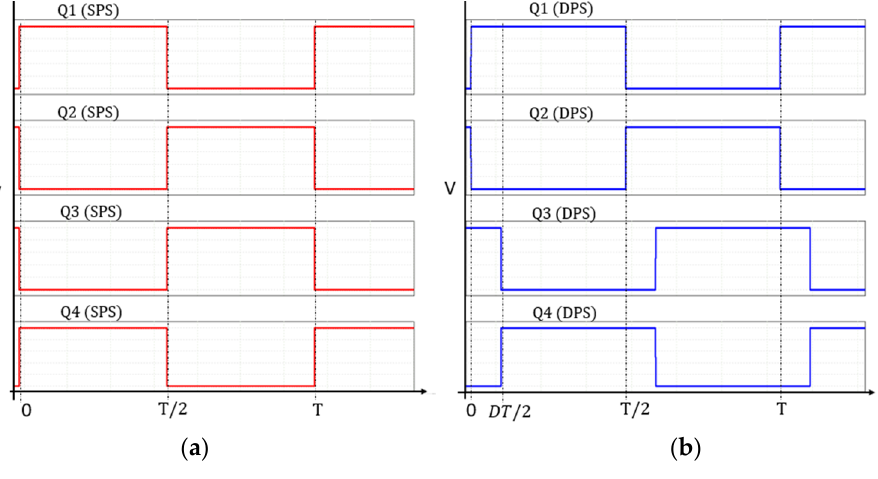
Figure 4. Switching cycle for port 1 ( a ) SPS control ( b ) DPS control.